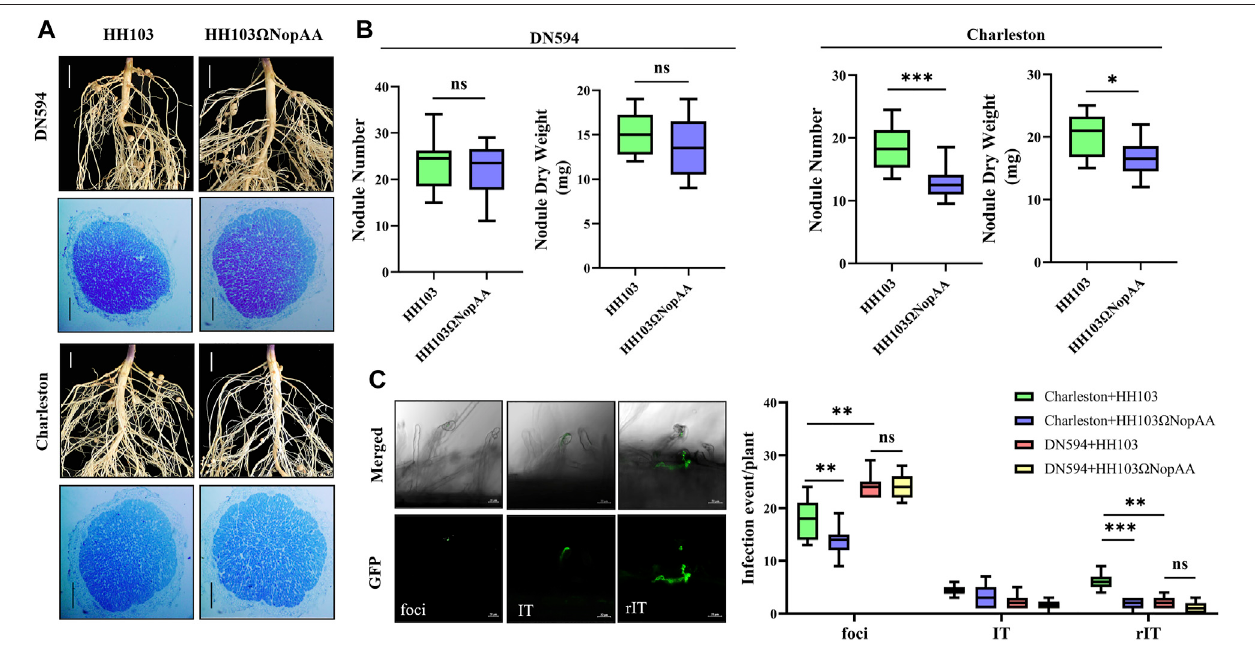
FIGURE 2 | Differences in infection events between DN594 and Charleston after inoculation with HH103 or the NopAA mutant. (A) Phenotypes of DN594 and Charleston inoculated withHH103 and HH103 Ω NopAA; rootphenotype scalebars represent0.5 cm; toluidineblue stainingofnodules scale bars represent 50 μ m. (B) Boxplots of NN and NDW. (C) Boxplots of the total number of infection events per plant of Charleston and DN594 (1 dpi). Data are presented as the average of three different biological replicates and ten root segments for each replicate, and all results were analyzed for signi fi cance using t -tests. Foci, infection foci; IT, infection thread in an epidermal cell; rIT, infection thread extending into a cortex cell. dpi, day